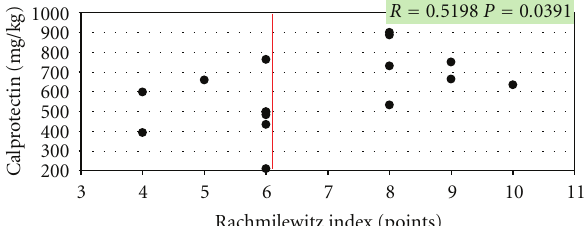
Figure 2: Correlation between calprotectin concentrations and the PCDAI score in CD children.